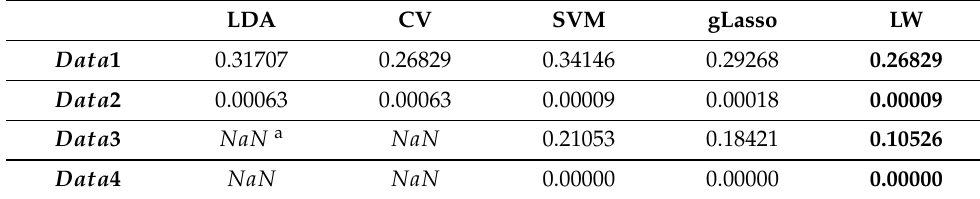
Table 5. Misclassification error for the real datasets in Table 4.